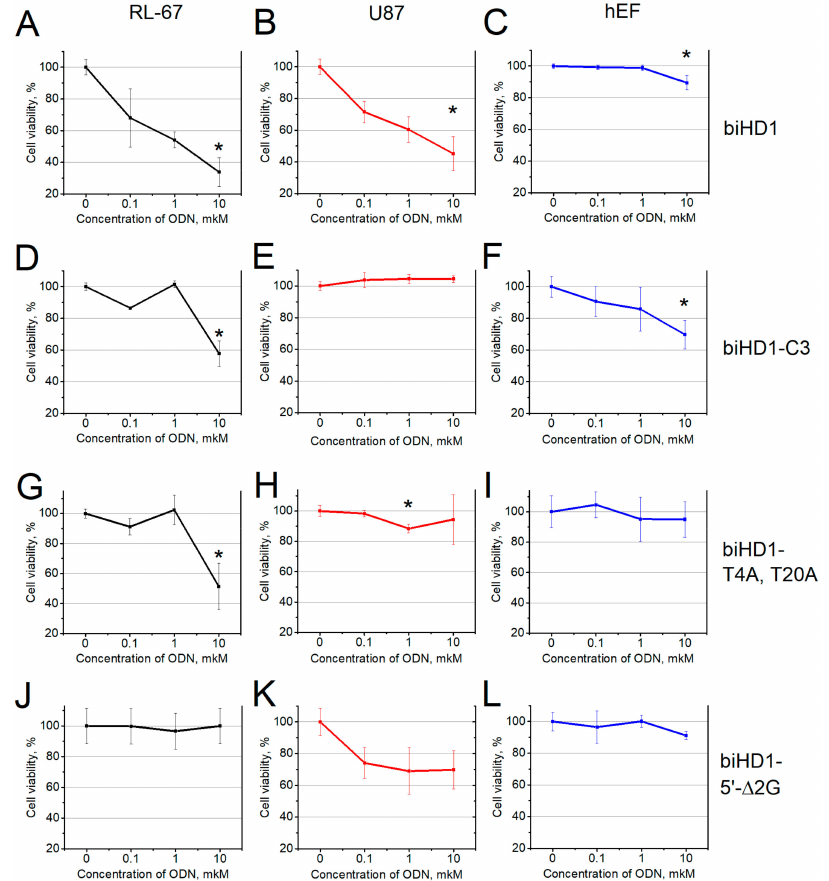
Figure 2. Cell viability according MTT test for oligonucleotides: ( A – C )—biHD1; ( D – F )—biHD1-C3; ( G – I )—biHD1-T4A,T20A; ( J – L )—biHD1-5 (cid:48) - ∆ 2G; results are presented for human cancer cell lines RL-67 ( A , D , G , J ), U87 ( B , E , H , K ), and embryonic fibroblasts ( C , F , I , L ) after 72 h incubation with di ff erent concentrations of oligonucleotides: Control experiment without oligonucleotides, 0.10, 1.0, and 10 µ M. Data are presented as mean ± S.D. * marks p < 0.05 compared with control (w / o